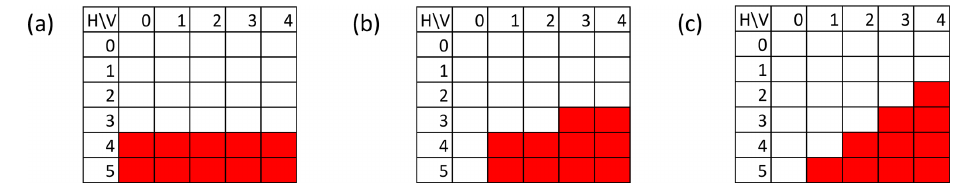
Figure 3. Examples of combination of hazard (H) (vertical) and vulnerability (V) (horizontal) to define the areas at risk with regards to runoff (red cells) when (a) vulnerability of stakes is not taken into account and IRIP hazard levels 4 and 5 are considered at risk and (b) and (c) vulnerability of stakes is taken into account in various manners based on the principle in which “the higher the vulnerability, the lower the hazard level triggering risk”. Table 3. Evaluation criteria used in the study. In the computation of the χ 2 test, the number of degrees of freedom is 1.